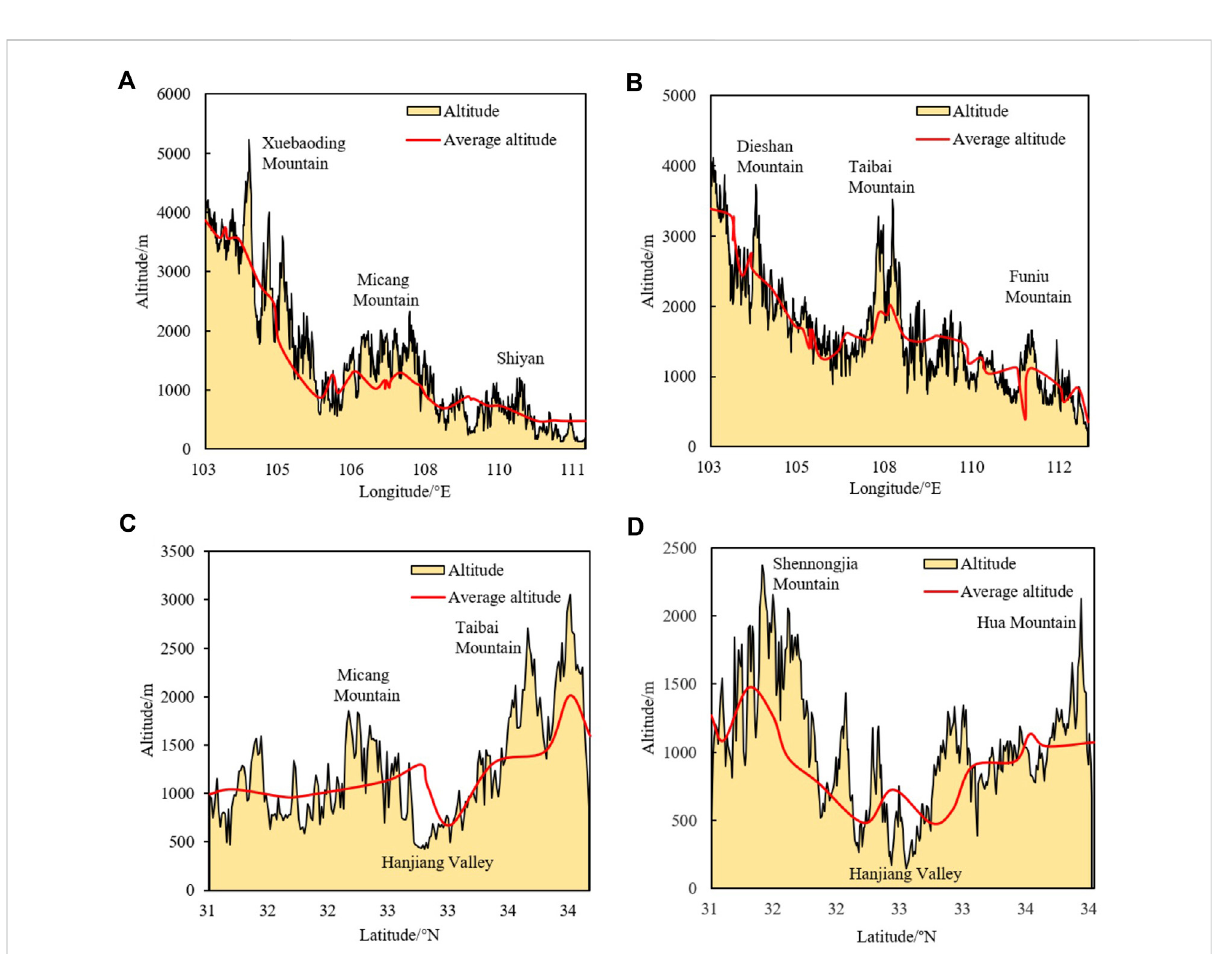
FIGURE 8 Altitude and average altitude along four pro fi les of (A) 32.67 ° N, (B) 33.96 ° N, (C) 107.81 ° E, and (D) 110.53 ° E in the Qinling-Daba